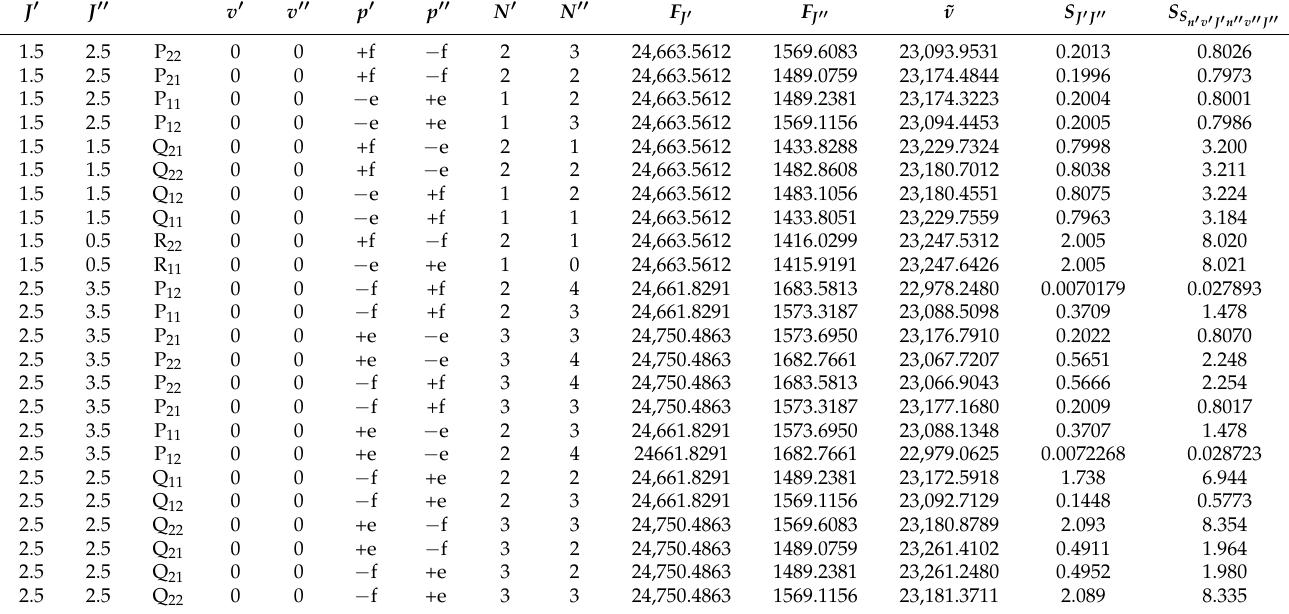
Table 1. First two dozen of 1384 lines for the CH A 2 ∆ ↔ X 2 Π line strength table with column headings: J (cid:48) upper and J (cid:48)(cid:48) lower total angular momentum quantum numbers (nuclear spin not